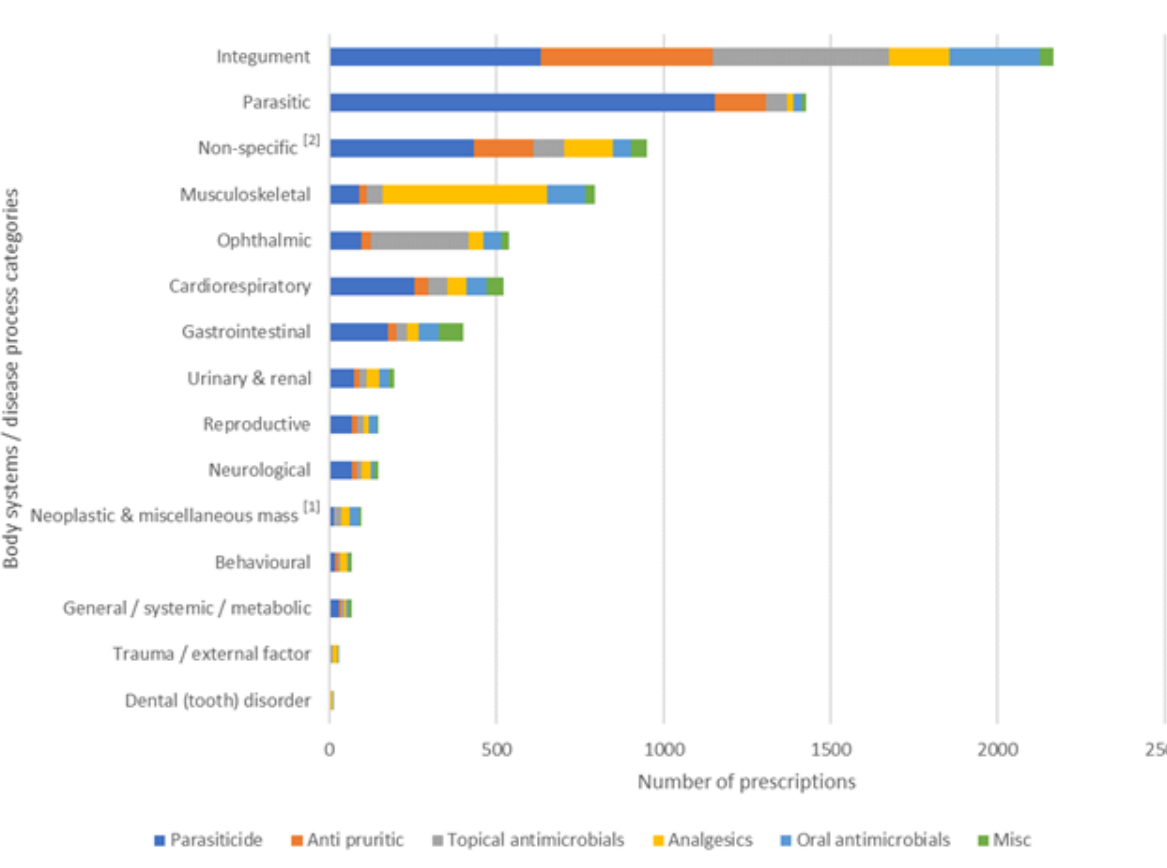
Figure 9: Medication class subsets for remote POM-V / POM prescriptions for the audit period grouped by body system / disease